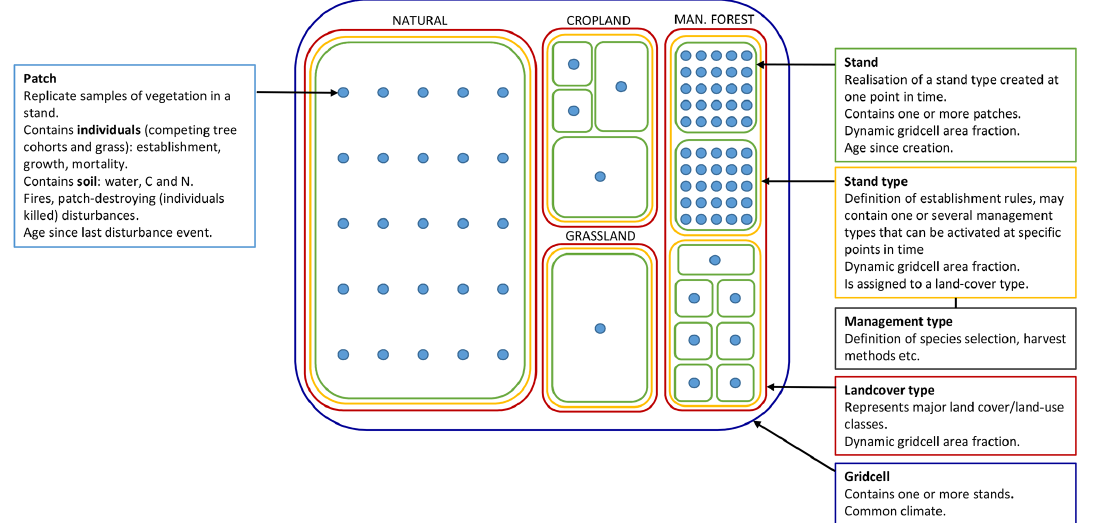
Figure 1. Data structures in LPJ-GUESS relevant for this study. Patch number is defined separately for PNV and secondary stands. If a secondary stand is created from PNV or managed forest with intact vegetation, the patch number of the parent stand is used. During land- cover change events, stands belonging to forest stand types can only be reduced in size. Expansion of such stand types results in new